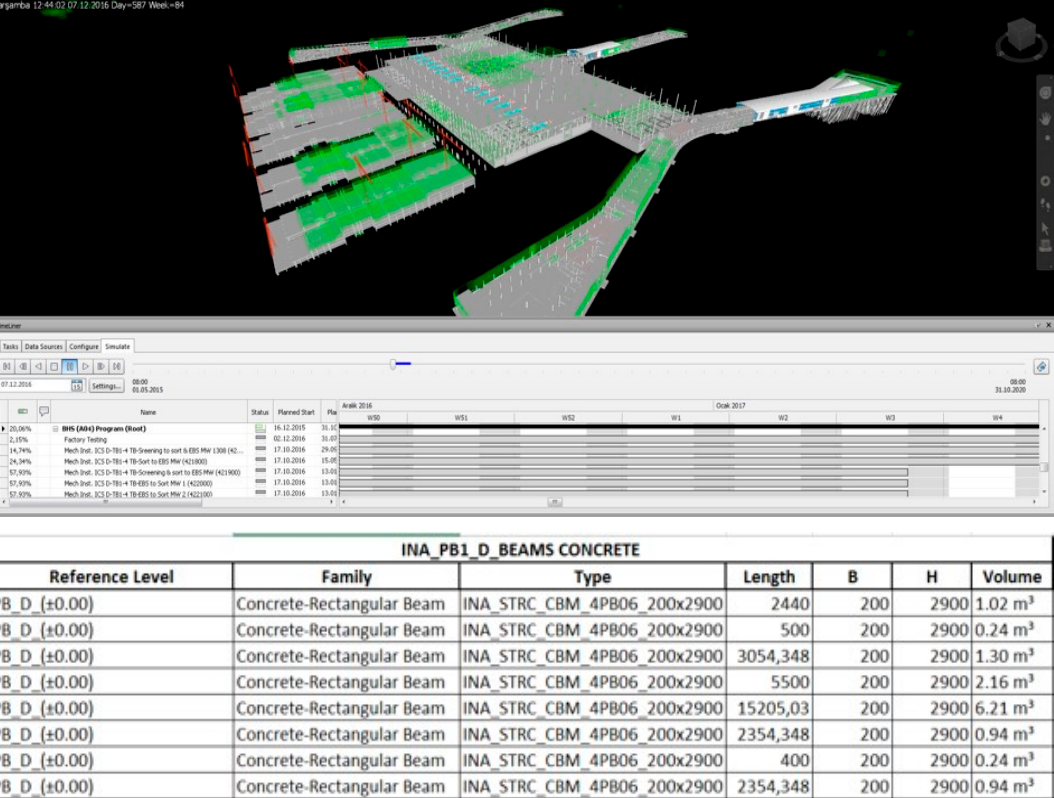
Figure 7. INA BIM Tools.